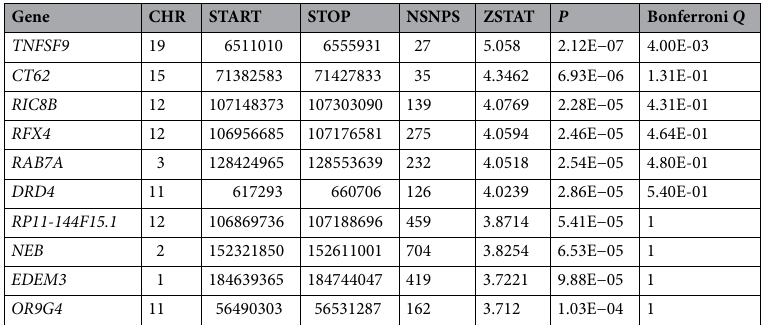
Table 3. Genes associated with the SMI by gene-based association analysis using MAGMA. Input SNPs were mapped to 18,870 protein-coding genes. CHR, chromosome; START/STOP, the annotation boundaries of the gene on that chromosome; NSNPS, the number of SNPs annotated to that gene that was found in the data; ZSTAT, the Z-value for the gene based on its (permutation) p-value; P , the gene p -value, using asymptotic sampling distribution; Bonferroni P, Bonferroni adjusted q -value (significant threshold = 0.05/18,870 = 2.65E−6).